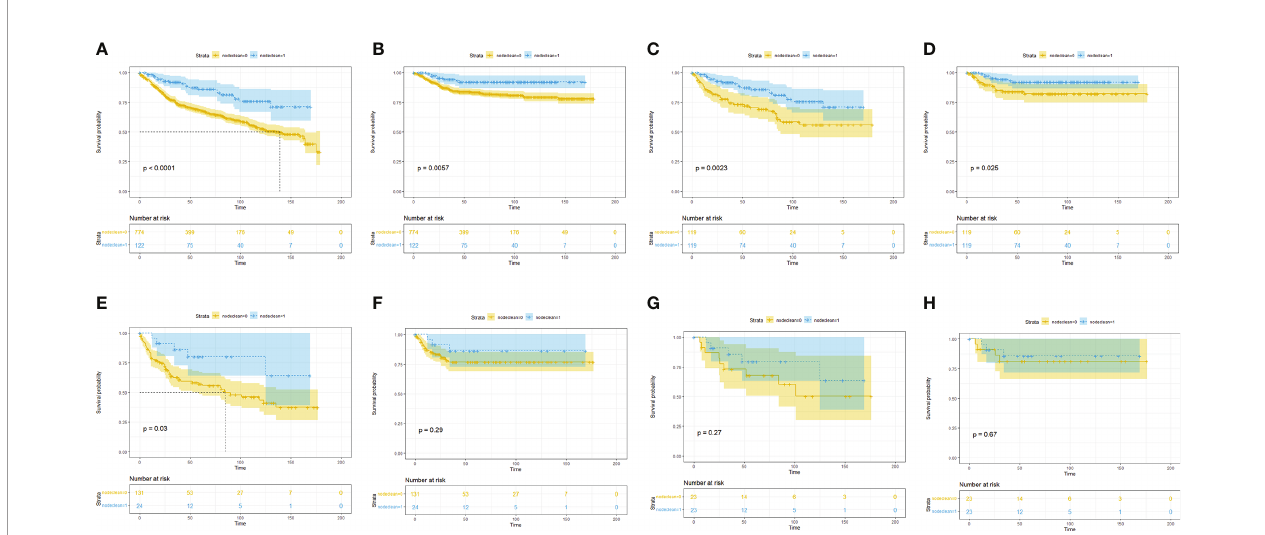
FIGURE 3 | Subgroup Kaplan – Meier survival analysis for LND. (A) Overall survival in the grade 1/2 subgroup based on the full cohort. (B) Cancer-speci fi c survival in the grade 1/2 subgroup based on the full cohort. (C) Overall survival in the grade 1/2 subgroup based on the PSM cohort. (D) Cancer-speci fi c survival in the grade 1/2 subgroup based on the PSM cohort. (E) Overall survival in the grade 3/4 subgroup based on the full cohort. (F) Cancer-speci fi c survival in the grade 3/4 subgroup based on the full cohort. (G) Overall survival in the grade 3/4 subgroup based on the PSM cohort. (H) Cancer-speci fi c survival in the grade 3/4 subgroup based on the PSM cohort.